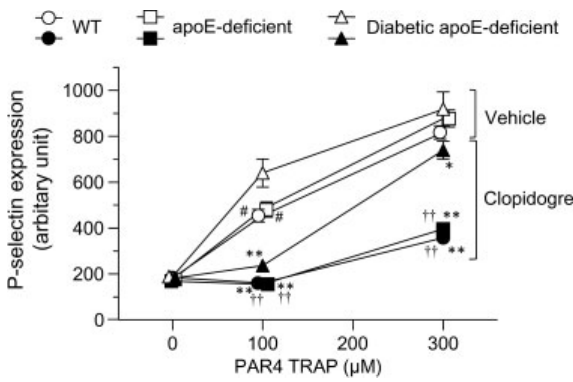
Fig. 6 Effects of clopidogrel on PAR4 TRAP-induced expression of platelet P-selectin. Clopidogrel (10 mg/kg/d) or vehicle was administered orally once daily for 5 days to wild-type (WT), apoE-de fi cient, and diabetic apoE-de fi cient mice, and blood collected 2 hours after the last dose. Ex vivo expression of P-selectin on platelets induced by 100 and 300 µM PAR4 TRAP was assessed using a fl ow cytometer. In the vehicle groups, PAR4 TRAP stimulation resulted in a signi fi cant increase in platelet P-selectin expression compared with no agonist ( p < 0.001, all groups). The results are presented as the mean (cid:4) SE ( n ¼ 10). (cid:5) p < 0.05, (cid:5)(cid:5) p < 0.01 versus corresponding vehicle group; # p < 0.05 versus the vehicle group of diabetic apoE-de fi cient mice; †† p < 0.01 versus clopidogrel group of diabetic apoE-de fi cient mice (Student ’ s t